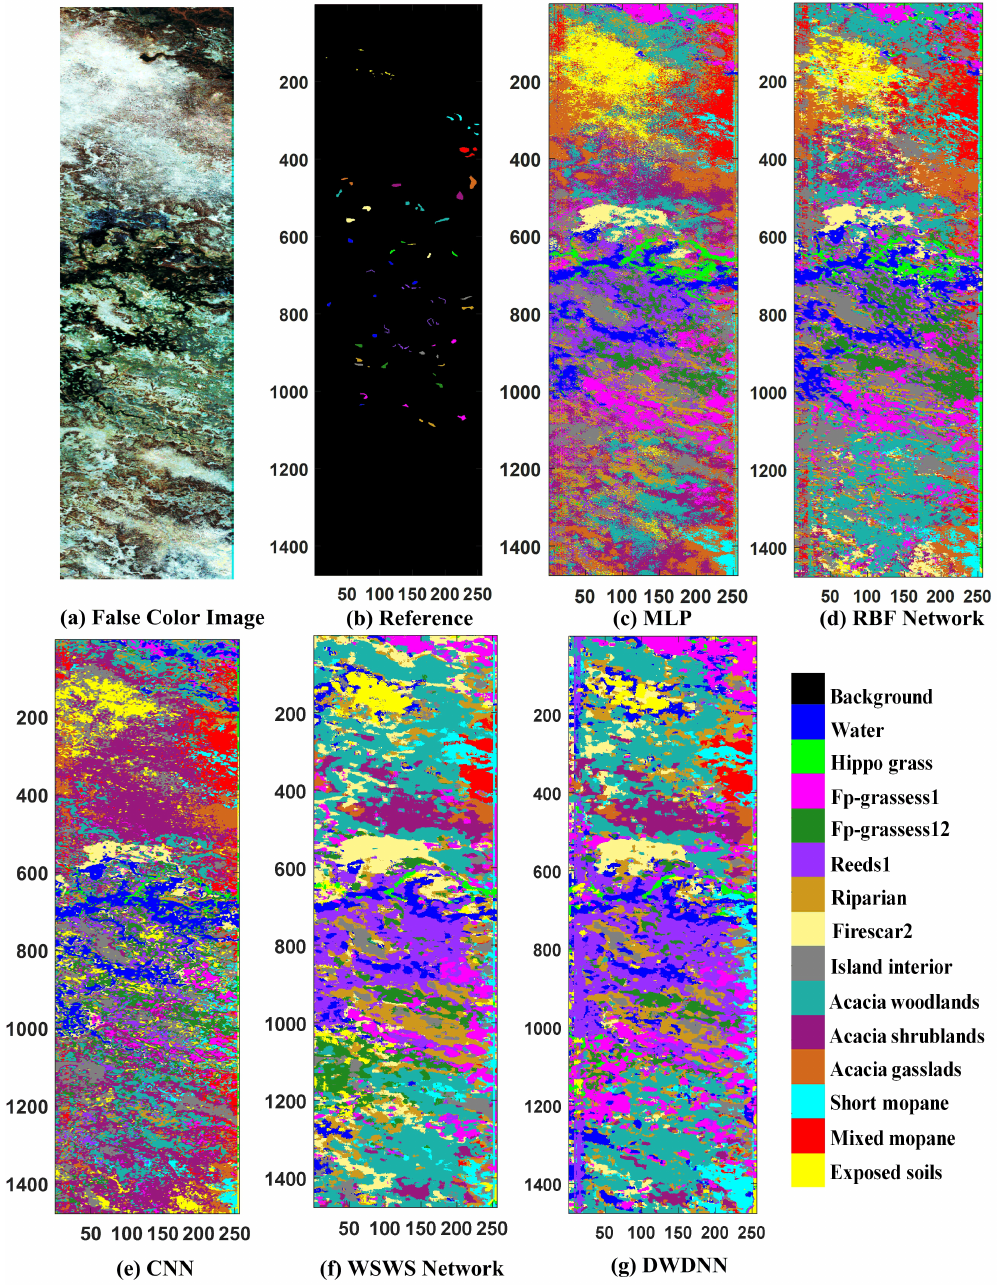
Figure 5. Classification results of the Botswana dataset (the instances without class information were also predicted). ( a ) False color image, ( b ) reference image, ( c ) MLP, ( d ) RBF network, ( e ) CNN, ( f ) WSWS network, and ( g ) DWDNN. The classification results for the Pavia University dataset are shown in Table 4 and Figure 6. The proposed DWDNN had the highest classification results compared with the other methods. The OA, AA, and Kappa coefficient of the DWDNN were 99.69%, 99.31%, and 99.59%, respectively. The test accuracy for each class in the table represents the percent- age of samples that could be classified correctly among the total number of samples in the corresponding class. Figure 6 shows the predicted results of the whole hyperspectral image. The instances without class information were predicted. The proposed DWDNN and the compared WSWS Net had smoother classification results than other compared methods. For example, the predicted classes of bare soil with brown color and trees with green color in Figure 6g are much smoother than the predicted results of the compared